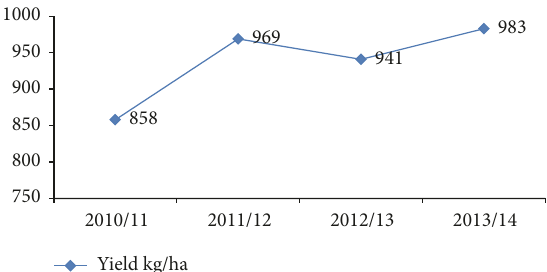
Figure 2: Cultivation area and production of buckwheat in Nepal from 2010 to 2014. Figure 3: Yield of buckwheat in Nepal from 2010 to